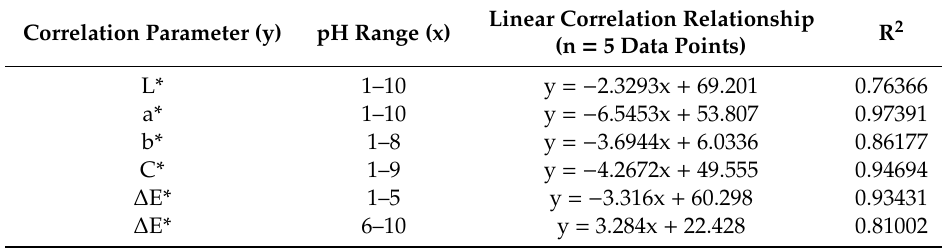
Table 3. Quantitative data on the linear relationship between color parameters (L*, a*, b*, C* and ∆ E*) and